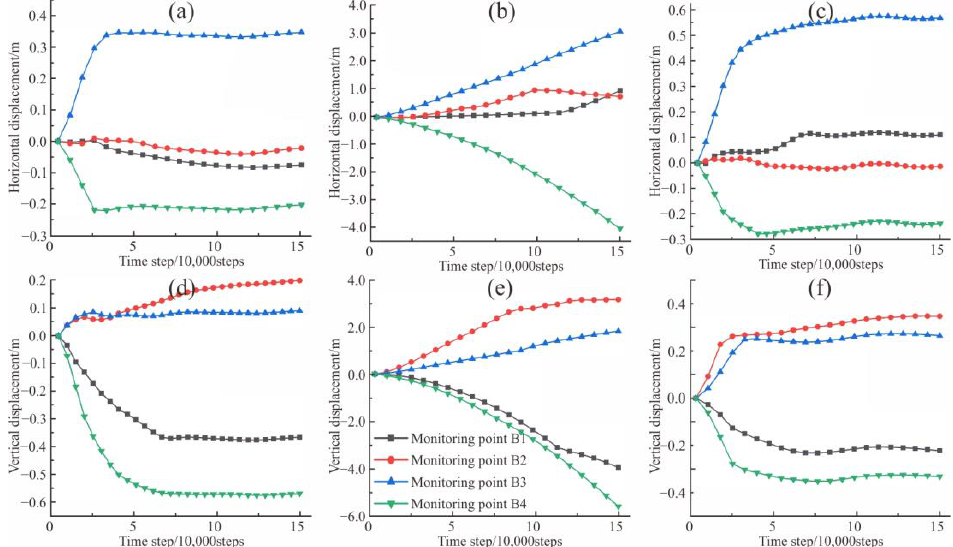
Figure 9. Displacement curves of the four monitoring points around the excavation area. ( a ) Horizontal displacement under the condition of backfill mining without fissures; ( b ) horizontal displacement under the condition of mining with fissures; ( c ) horizontal displacement under the condition of backfill mining with fissures; ( d ) vertical displacement under the condition of backfill mining without fissures; ( e ) vertical displacement under the condition of mining with fissures; and ( f ) vertical displacement under the condition of backfill mining with fissures.